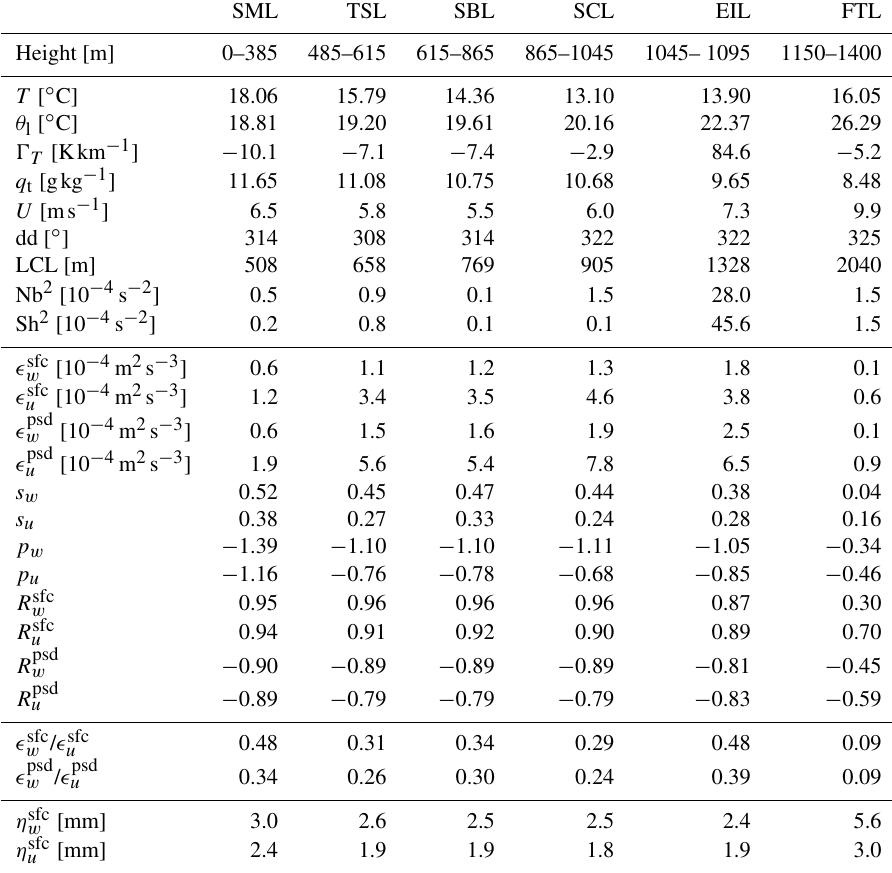
Table A2. Average conditions inside the sublayers in the case of decoupled STBL (flight no.